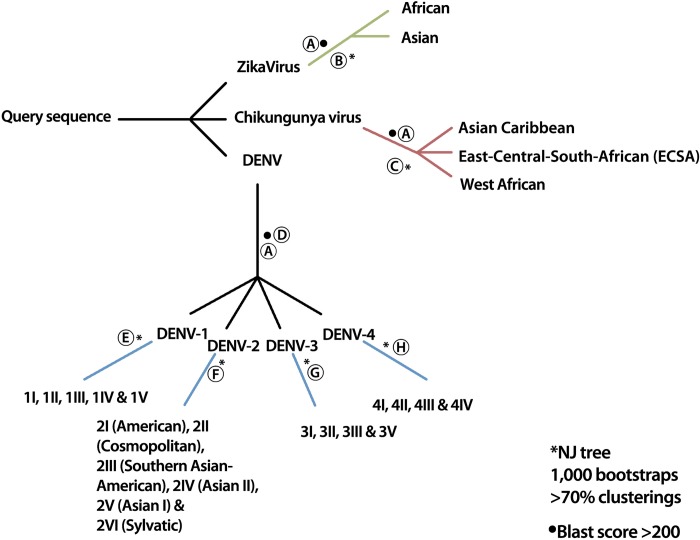
Outline of the classification procedure.Firstly (A), the viral species is determined using BLAST. When the submitted sequence is a Zika virus, a Neighbor joining tree is constructed to determine the Zika genotype (B). When the submitted sequence is a Chikungunya virus, a Neighbor joining tree is constructed to determine the Chikungunya genotype (C). When the submitted sequence is a Dengue virus, the serotype is determined using another BLAST invocation (D). Based on the inferred serotype, a serotype specific Neighbor joining tree is constructed to determine the Dengue genotype (E, F, G, H).